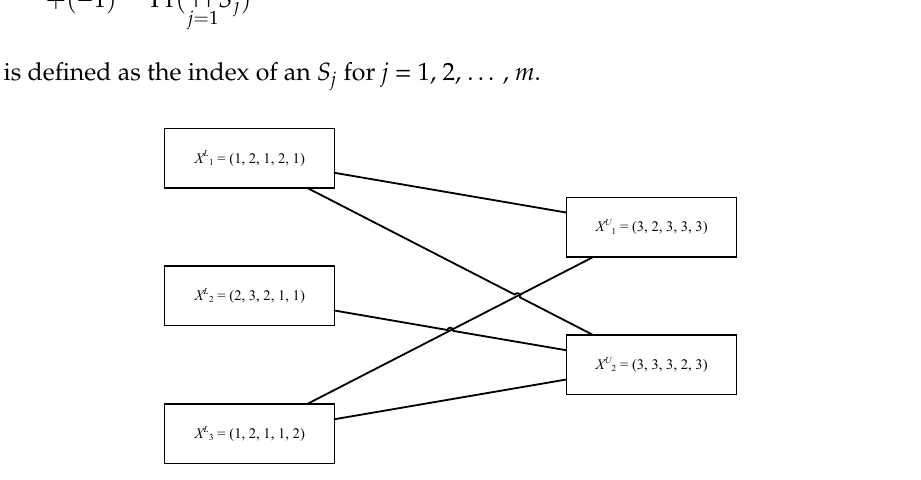
Figure 1. An example of upper and lower boundary points.